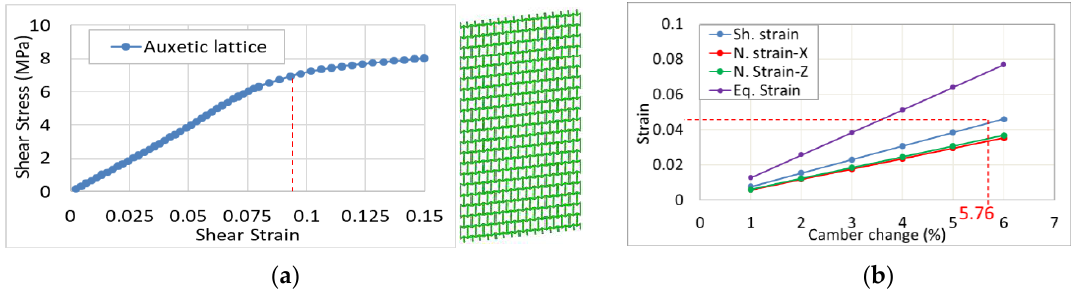
Figure 13. ( a ) In-plane shear stress/strain curve and ( b ) percentage of camber change vs. corresponding strain.